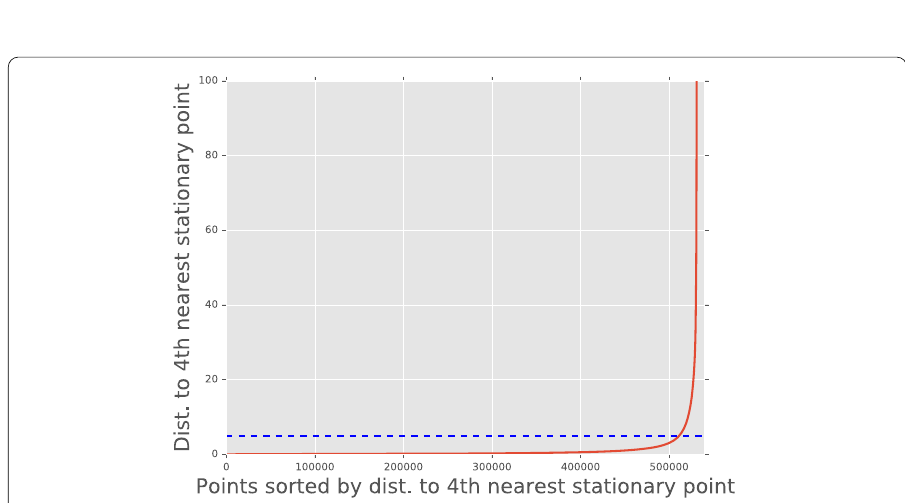
Figure 2 Converting the raw data for participant i into a suitable time series, T bins plot the data points onto a world map overlaid with square grid cells with side lengths (cid:3) s . This converts each data point into a location represented by a square grid cell and encoded by a symbol in T bins i . The location data is then resampled such that each bin in T bins i corresponds to a time interval (cid:3) t . This mobility encoding is similar to that of earlier works and corresponds to the location in a sequence of time bins. We propose to look at a the sequence of locations instead.